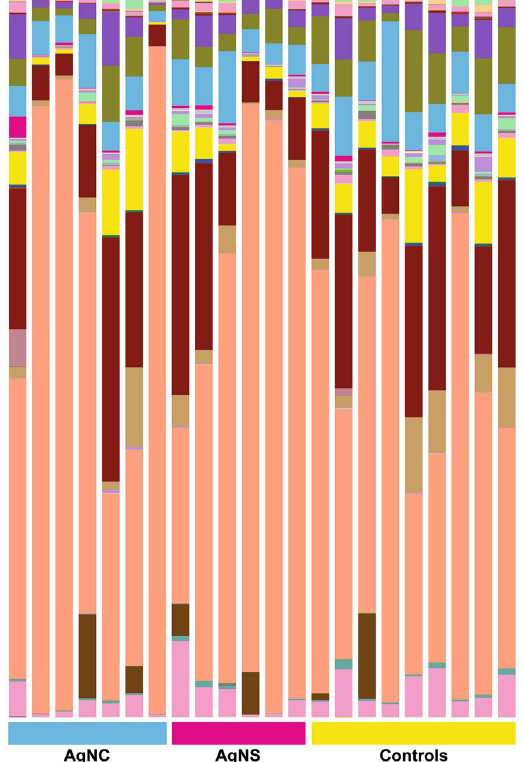
Figure 6. Bar plot of fecal microbiome data from AgNC, AgNS, and control groups. Bar plot analysis of the most abundant bacterial classes in all three-treatment groups.